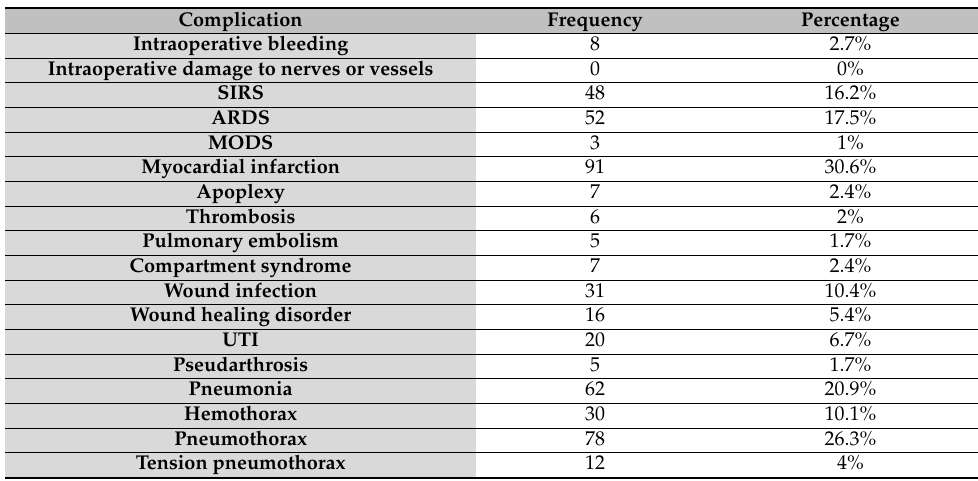
Table 4. Detailed overview of